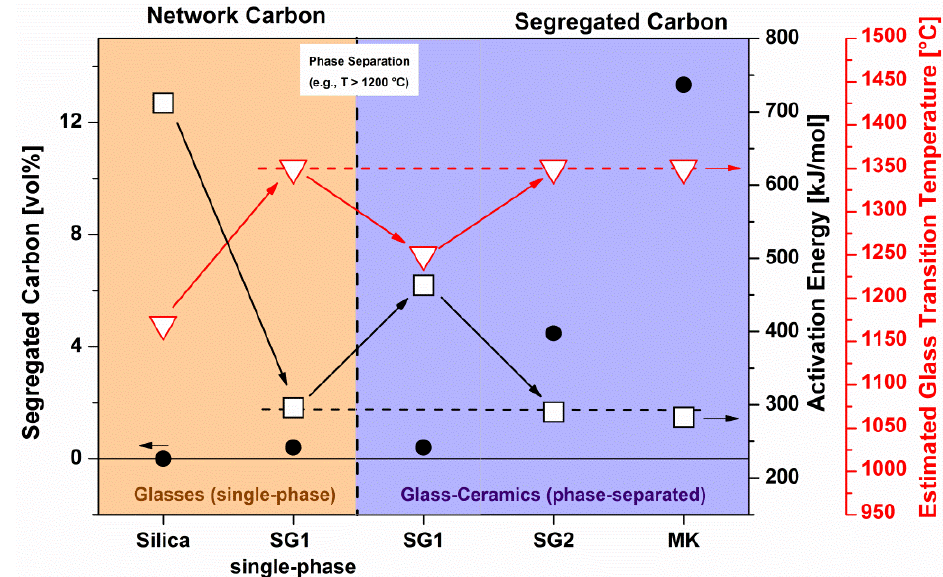
Figure 16. Dependence of the activation energy (red triangles) and T g (black squares) on the content of segregated carbon (filled circles) in silicon oxycarbides (reprinted with permission from Wiley) [338].